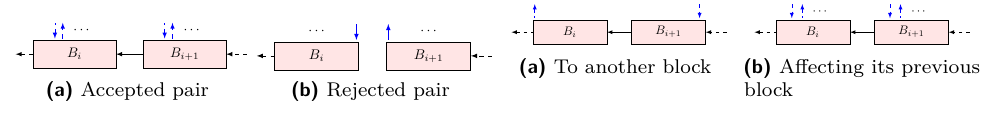
Figure 5: Types of block pair Figure 6: Transfer of bits in a